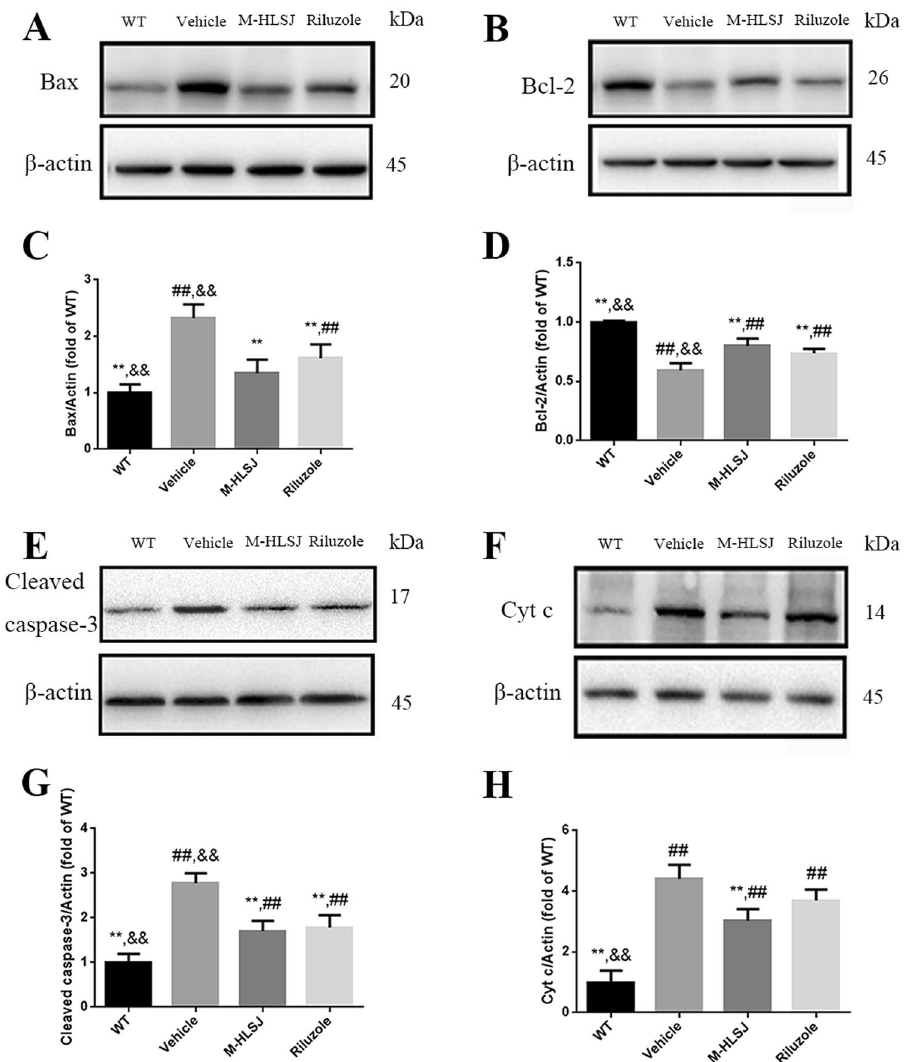
Figure 5. Effects of HLSJ on the expression level of apoptosis-related proteins in the spinal cords of SOD1 G93A mice. Western blot analysis of proteins level of ( A ) Bax and ( B ) Bcl-2. The quantitative analysis of the expression of ( C ) Bax and ( D ) Bcl-2; Western blot analysis of proteins level of ( E ) cleaved caspase-3 and ( F ) Cyt c, n = 3 in each group; The quantitative analysis of the expression of ( G ) cleaved caspase-3 and ( H ) Cyt c, n = 3 in each group. Significant differences with vehicle group at ** P < 0.01. Significant differences with WT group at ## P < 0.01. Significant differences with riluzole group at && P <